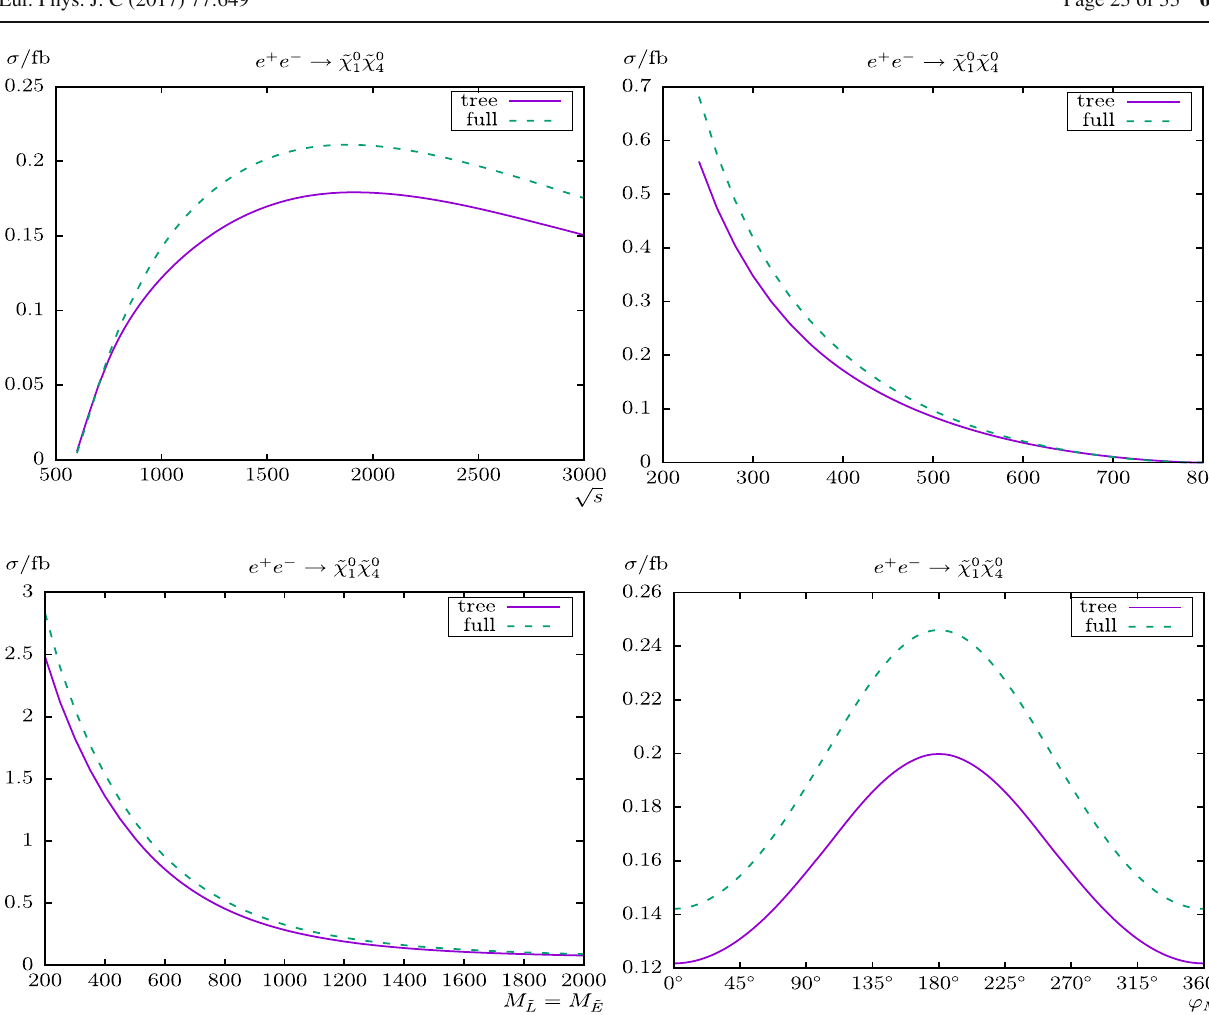
Fig. 20 σ( e + e − → ˜ χ 0 The upper plots show the cross sections with